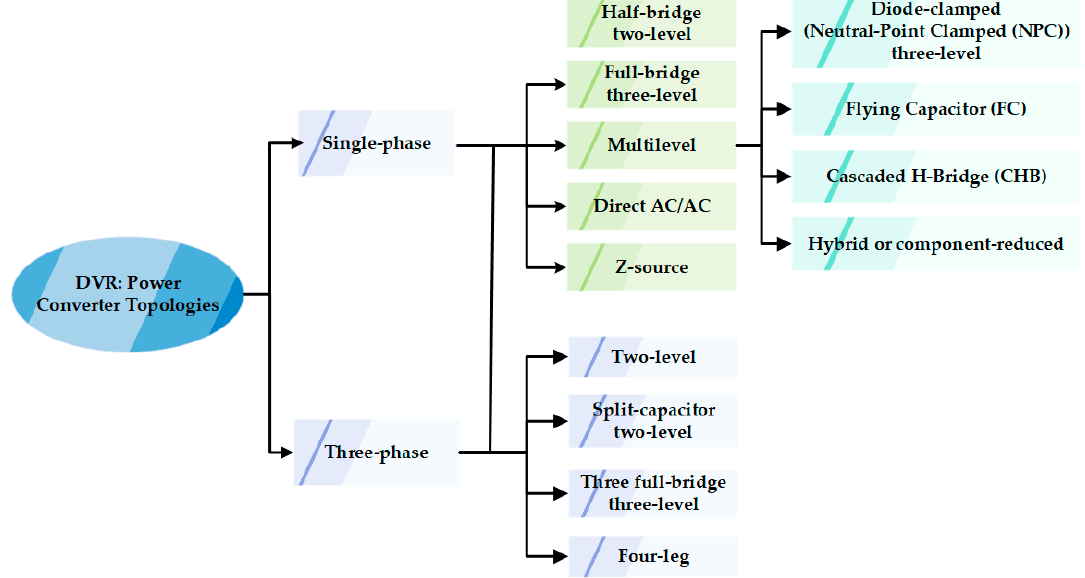
Figure 7. DVR topologies from the power converter perspective. Based on data from [55–62].